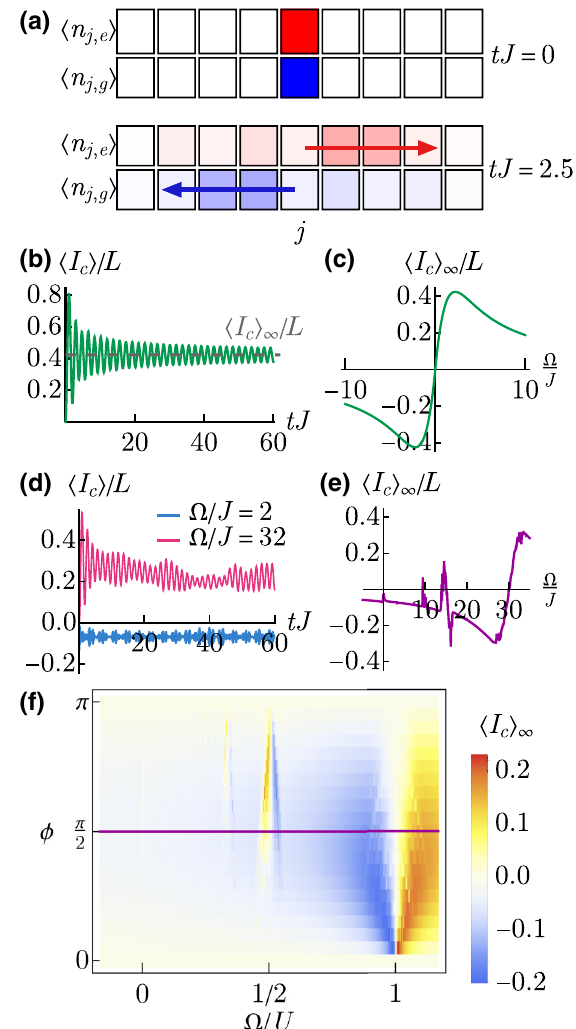
FIG. 2. (a) Time-evolution snapshots of populations (cid:12)ˆ n j , e (cid:4) , √ (cid:10) † (cid:12)ˆ n (cid:4) for a single-atom initial state | ψ (cid:4) = ( 1 / + 2 )( ˆ c 0 j , g 1 atom j = 0, e ˆ c (cid:10) † ) | 0 (cid:4) in the gauged frame. The parameters are (cid:2)/ J = 2 j = 0, g and φ = π/ 2. (b) Evolution of the chiral current for a nonin- teracting system U = 0 with flux φ = π/ 2, drive (cid:2)/ J = 2, and system size L → ∞ . (c) Long-time average current in terms of (cid:2)/ J for the noninteracting system using the same flux. The ana- lytic expression is given in Eq. (15). (d) Evolution of the chiral current for a strongly interacting system U / J = 30 with flux φ = π/ 2 and drive strengths (cid:2)/ J = 2, 32. System size is L = 9. (e) Average current for the interacting system with varying (cid:2)/ J , averaging over tJ = 0 to 500. (f) Average current for the strongly interacting system across the parameter space of (cid:2)/ U and φ . The violet line corresponds to panel